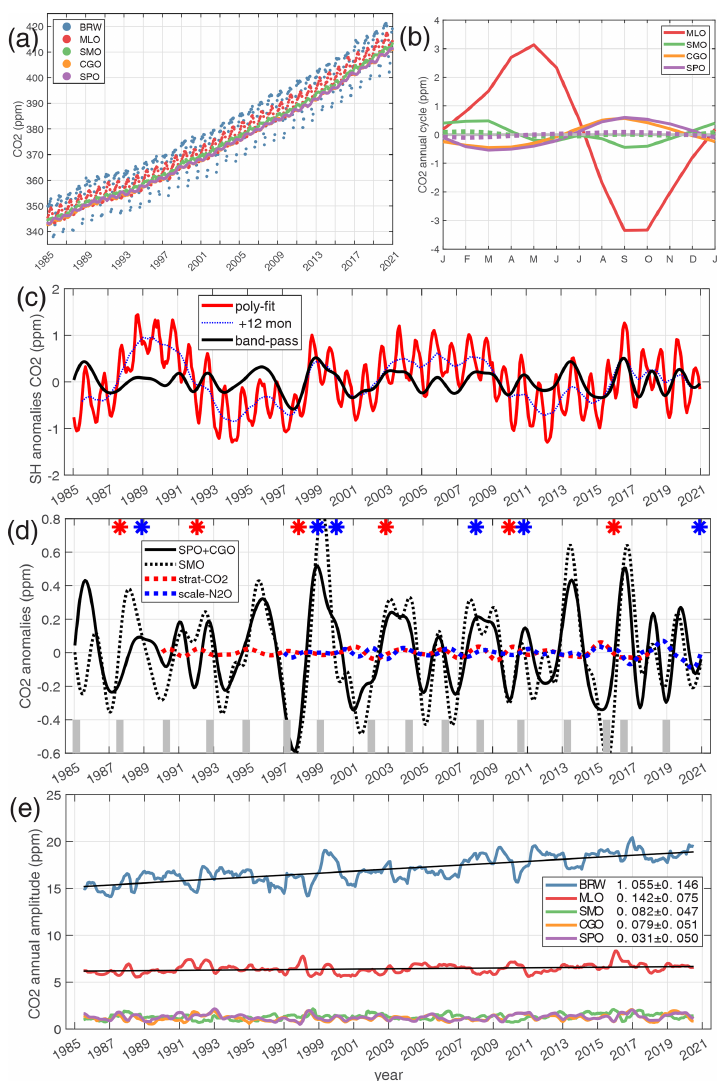
Figure 1. (a) NOAA surface CO 2 monthly data (ppm, mole fraction) from Dlugokencky et al. (2021b). The five sites are as follows: BRW – Barrow, AK (now Utqia˙gvik), at 71 ◦ N, 156 ◦ W; MLO – Mauna Loa, HI, at 20 ◦ N, 156 ◦ W; SMO – Tutuila, Am. Samoa, at 14 ◦ S, 171 ◦ W; CGO – Cape Grim, Tasmania, Australia, at 41 ◦ S, 144 ◦ E; SPO – South Pole at 90 ◦ S. Monthly average in situ observations are used with gaps filled by flask data at the same site. Only one point is interpolated (SMO, May 2015). CGO is flask only. (b) The mean annual cycle in surface CO 2 (ppm) at four sites (BRW not shown) using 1985 through 2021 calculated from the residuals after the polynomial fit was removed. The eCO2 model results are shown as dotted lines for SMO and SPO with the same color coding; eCO2 has similar phasing at SPO and is double-peaked at SMO, but the amplitudes ( ∼ 0 . 18ppm) are much smaller than observed. The sCO2 amplitude is even smaller ( ∼ 0 . 06ppm) and not shown. (c) Observed CO 2 variability (ppm) derived from the monthly averages of two SH extratropical stations (SPO and CGO) for the period 1985–2021. The poly-fit (solid red curve) shows the residuals after removal of a polynomial fit (average of third- and fourth-order in time). A 12-month running mean (thin dashed blue curve) is derived from the poly-fit residuals and removes the annual cycle. The interannual variability (IAV, solid black curve) is derived from bandpass filtering described in the text. The bandpass limits [0.20 0.80] are set to truncate periods longer than 5 years and shorter than 1.25 years. (d) Surface CO 2 IAV (ppm) for SH extratropics. The SPO + CGO IAV (black solid line) is compared with the SMO IAV (thin dotted black line). Other IAVs shown are (1) model-calculated sCO2 (dashed red line) from the stratosphere-driven influx of aged, low-CO 2 air and (2) N 2 O observed IAV (dashed blue line) scaled to match flux of low-CO 2 air. The timing of the QBO phase change in equatorial zonal wind at 40hPa from negative (easterlies) to positive (westerlies) is denoted with thick vertical gray bars. The timing of moderate to extreme El Niños (red stars) and La Niñas (blue stars) is also shown. (e) CO 2 annual amplitude (ppm, max–min) derived from the variance across 12-monthly values. Each monthly point (centered on the beginning of each month) is the standard deviation of the surrounding ± 6-monthly means, scaled by 2 × 2 . 5 to give the max–min amplitude as if it were a sine curve. The line fits for BRW and MLO are shown. The slope and standard error (SE) in units of parts per million (ppm) per decade are given in the legend. The SE is calculated conservatively based on the number of years rather than the number of months. Earth Syst. Dynam., 13, 703–709, 2022